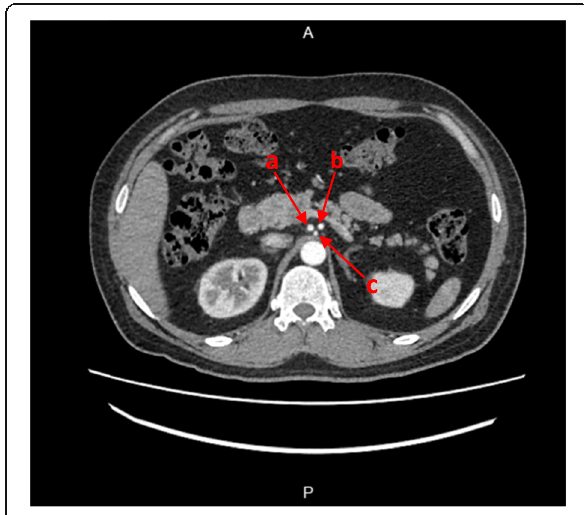
Fig. 1 Abdominal CT scan (contrast) in arterial phase demonstrating the common hepatic artery ( a ), splenic artery ( b ), and left gastric artery ( c ) arising independently from the abdominal aorta